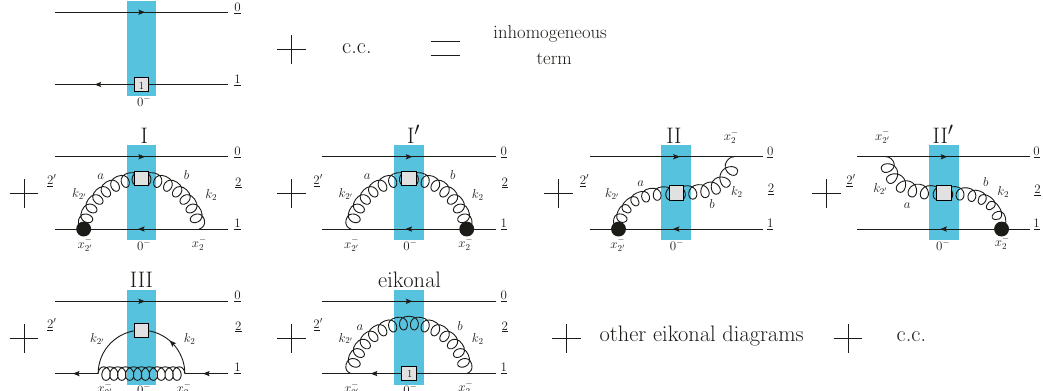
Figure 3. Diagrams representing the evolution of the fundamental polarized dipole amplitude Q 10 . The vertical shaded rectangle represents the shock wave. The square box on the gluon and quark lines represents the sub-eikonal interaction with the target given by eq. (2.10) for gluons and eq. (2.5) for quarks. The same square box, but with number 1 in it, on the quark line denotes the interaction described by V pol[1] only. The black circle denotes the sub-eikonal quark-gluon vertex 1 , which, in turn, generated by the F 12 operator in eq. ( 2.7a), that is, by the F 12 part of V pol[1] 1 contributes to Q 10 through eq. (4.1). All momenta flow to the